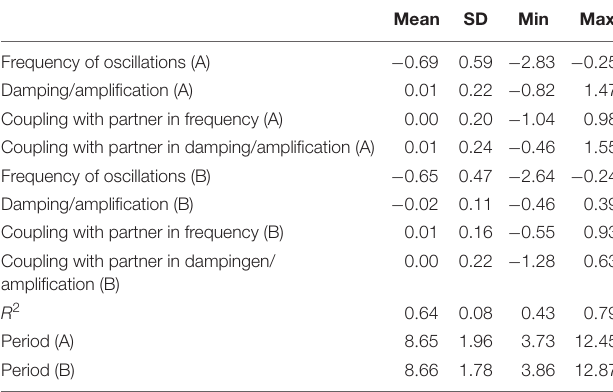
TABLE 2 | Summary of CO model parameters across the 133 contexts completed by 34